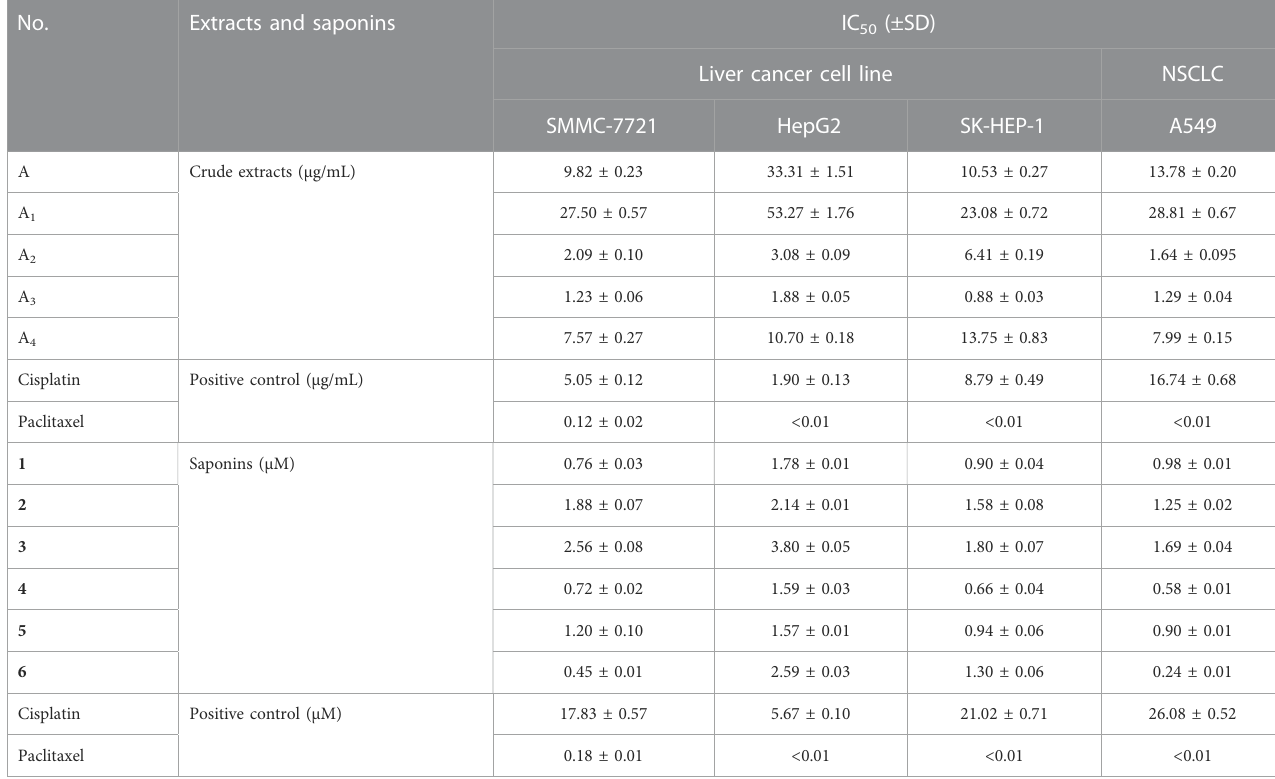
TABLE 2 IC 50 values for crude extracts and saponins (1 – 6) from P. polyphylla var. yunnanensis against four human cancer cell lines.